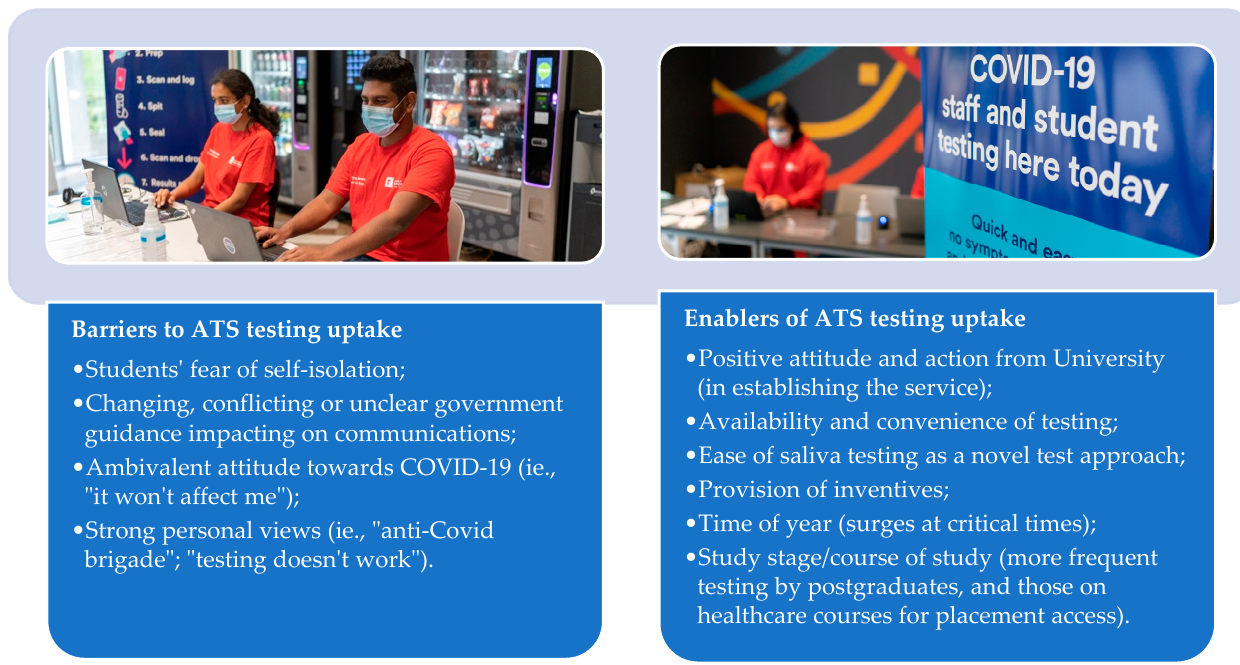
Figure 3. Barriers and enablers of ATS testing.